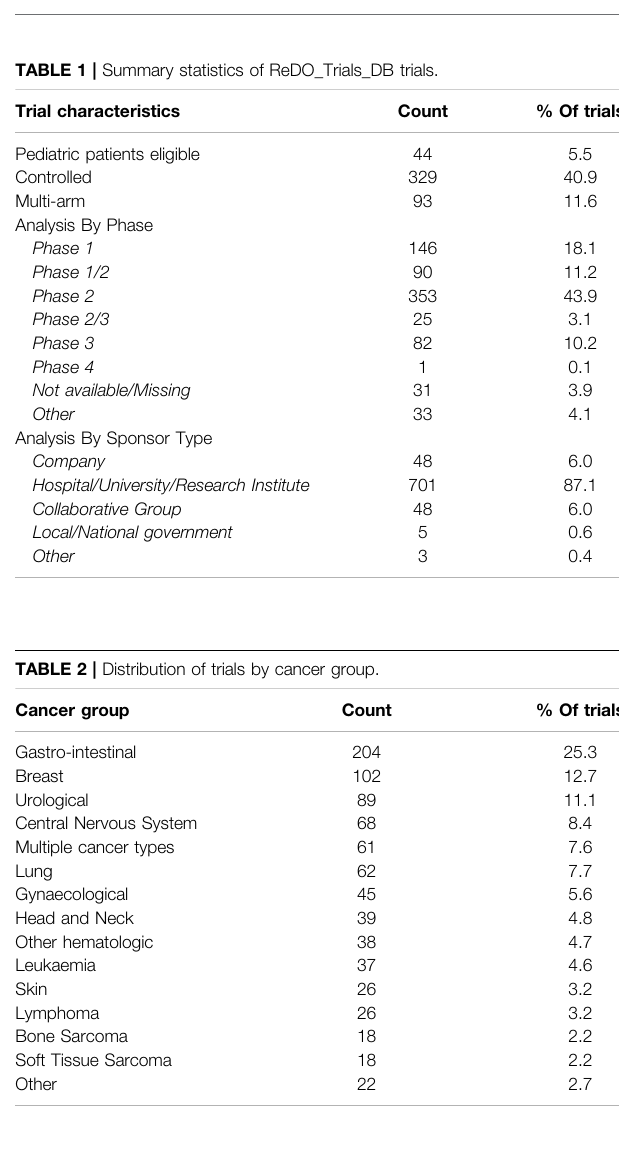
Table 1 . As of the WHO ICTRP database update of August